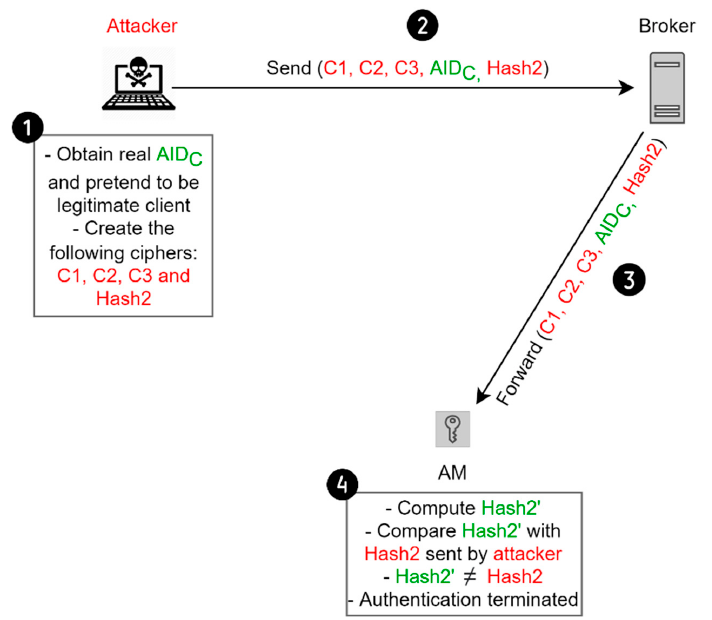
Figure 9. Impersonation attack.